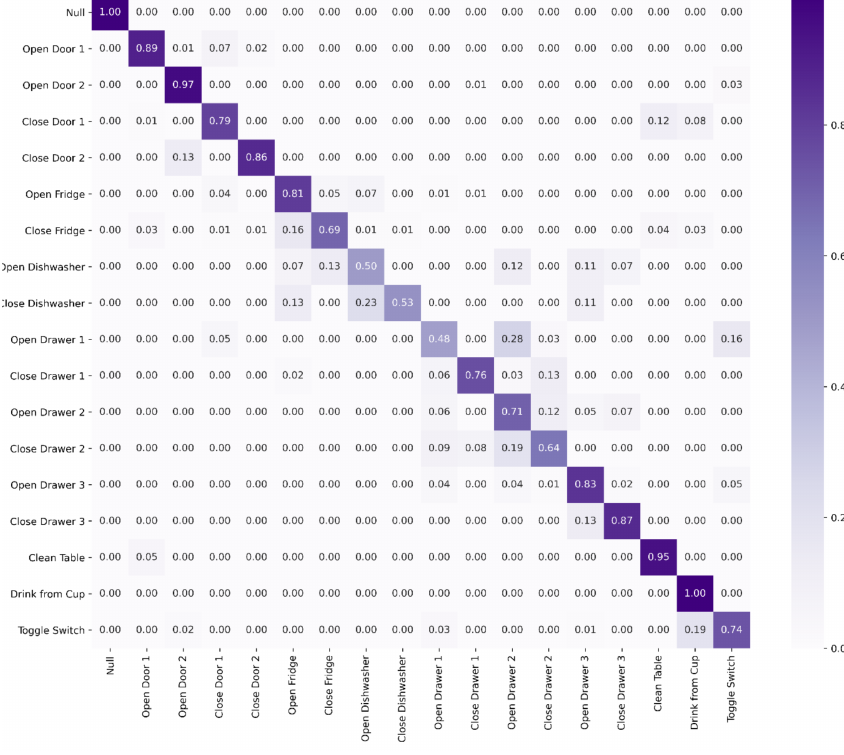
Figure 12. Confusion matrix of the model on testing dataset after